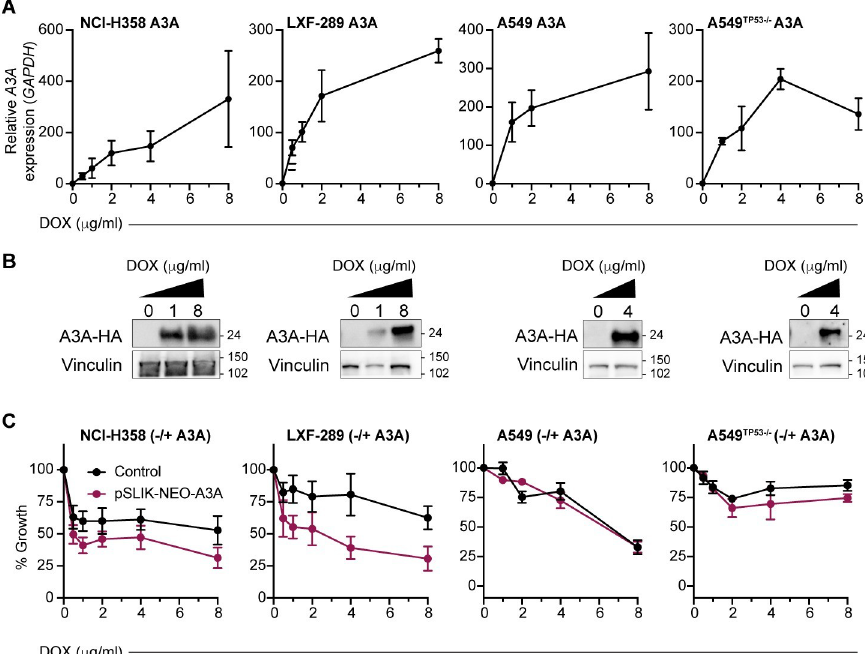
Fig 1. Inducible A3A expression reduces the fitness of LUAD cell lines. ( A ) A3A mRNA levels in NCI-H358, LXF- 289, A549, and A549 TP53 − / − cell lines transduced with a DOX-inducible A3A cassette at various concentrations of DOX. qRT-PCR and western blot analysis were repeated 2 times. ( B ) Western blot detection of HA-A3A upon DOX induction. LXF-289, NCI-H358, A549, and A549 TP53 − / − cells were collected and lysed 72 h posttreatment. Vinculin serves as a loading control, and molecular mass is indicated in kilodaltons. ( C ) Growth (percentage of growth rate relative to the cells without DOX) for the indicated cell lines after 72 h of DOX treatment measured with AlamarBlue. In red, cells transduced with the inducible A3A cassette, and in black, the parental cell line (no A3A) exposed to the same concentration of DOX. Growth assays were repeated 2 (A549 TP53 − / − ) or 3 times (all other lines). For all graphs, mean and SEM are shown. Uncropped western blots are provided in S1 Raw Images, and numerical data underlying plots are provided in S1 Data. A3A, APOBEC3A; DOX, doxycycline; HA, haemagglutinin; LUAD, lung adenocarcinoma; qRT-PCR, quantitative real-time